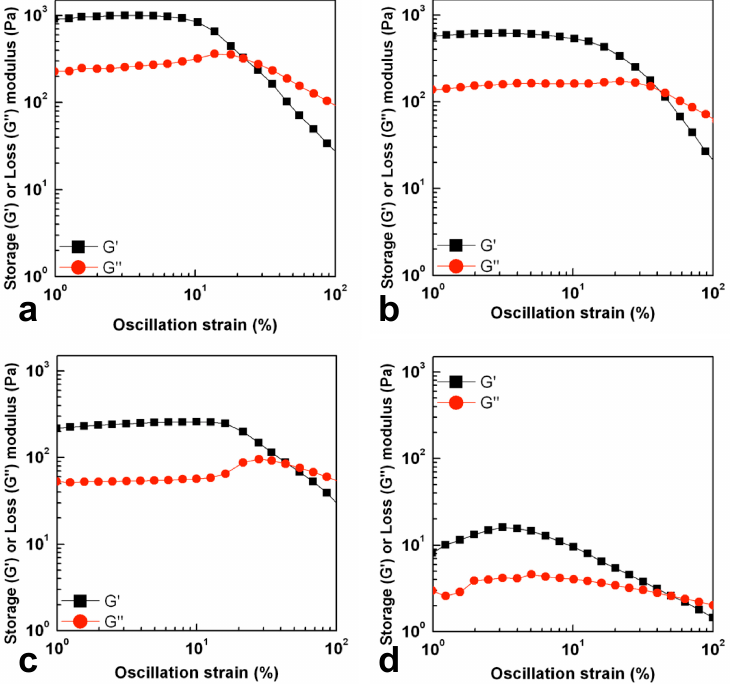
Figure 3. Strain sweep experiments performed at 0.1 Hz for hydrolysis product GG 4 ( a ), GG 6 ( b ), GG 8 ( c ) and GG 24 ( d ) dispersed in water at 5% w/v .